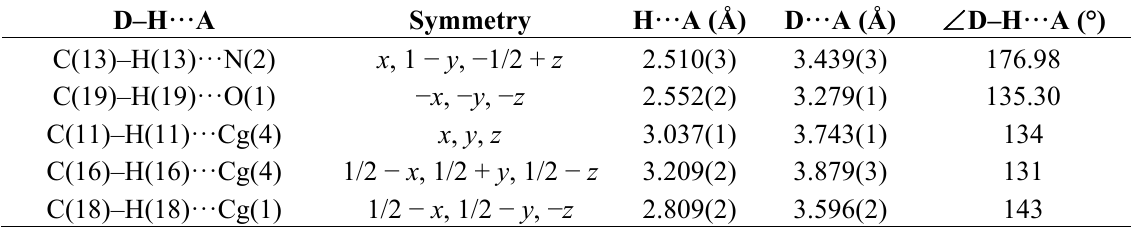
Table 2. Hydrogen bonds and C–H··· π supramolecular interactions a